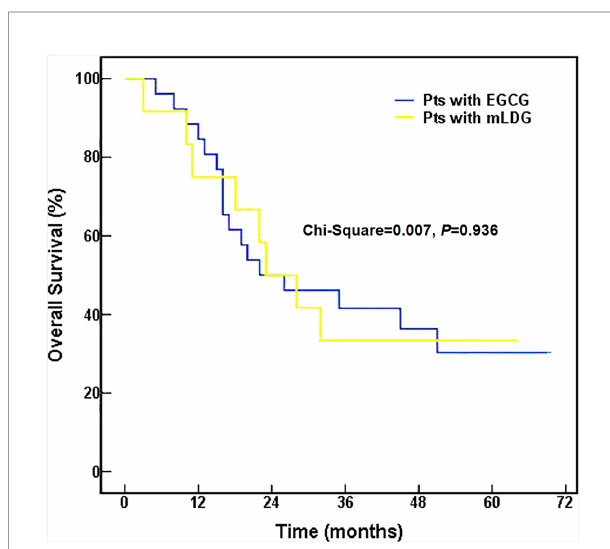
FIGURE 4 | Overall survival of SCLC patients (pts) treated with EGCG (blue) or mLDG (gold)